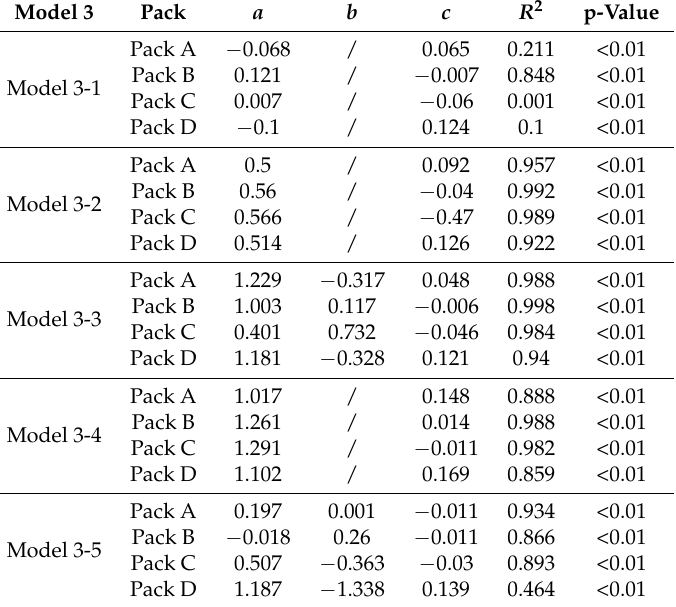
Table 5. Parameters and significance of the linear regression model of the four battery packs under Model 3.